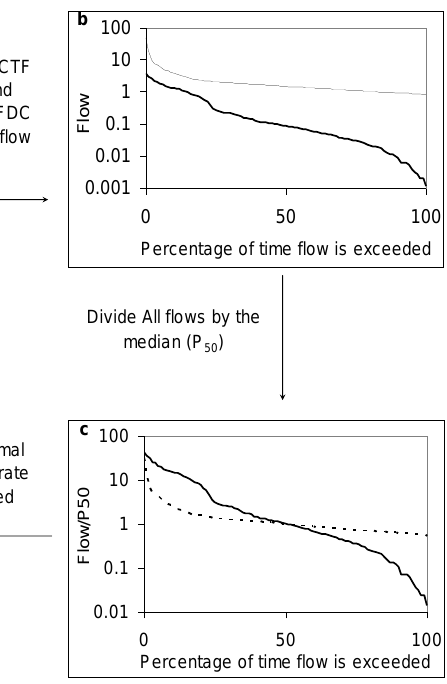
Fig. 1. Normalising the FDC to achieve common parameter Figure 1. Normalising the FDC to achieve common parameter space. 2